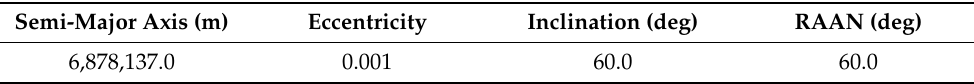
Table 2. Description of the simulated satellite.